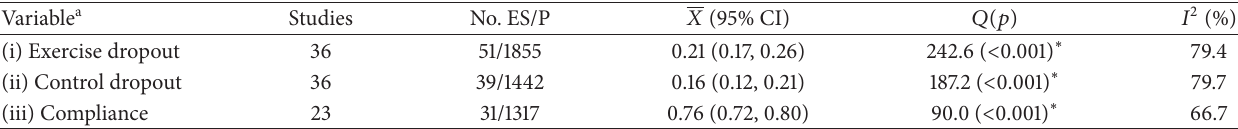
Table 1: Overall dropout and compliance results.